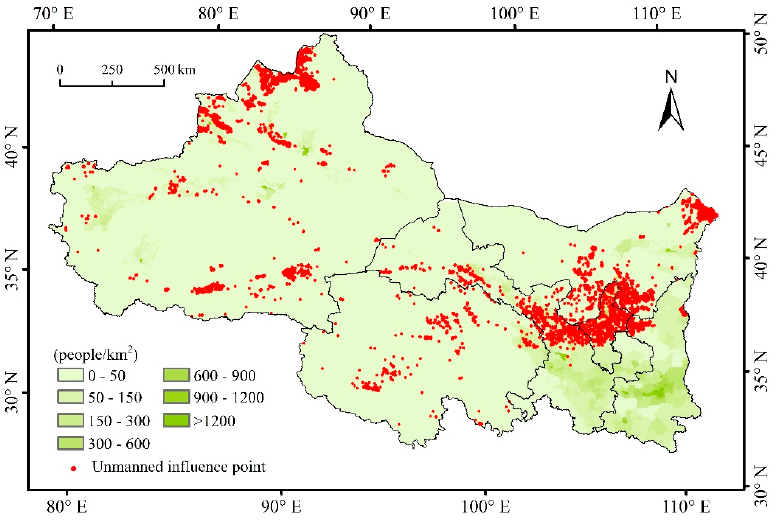
Figure 7. The grids (red dots) without human activities.